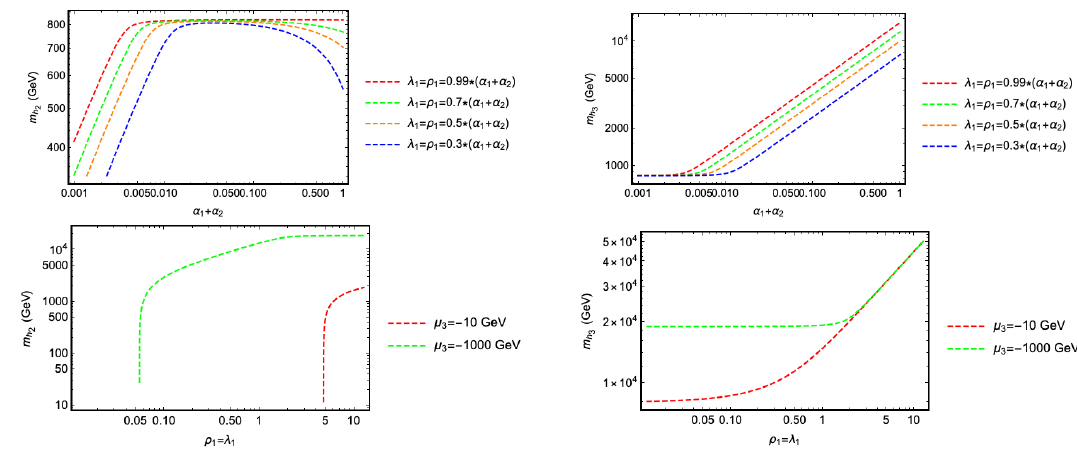
Figure 8 . Dependence on the Higgs mass on the couplings in the potential. Top left panel: h 2 Higgs mass as a function of α + α for various values of λ , in the lighter mass region; Top right 1 2 1 ρ 1 panel: same as in the left panel, but for h Higgs mass; Bottom left panel: h 3 function of λ = ρ , for two values of µ the heavier mass region; Bottom right panel: same as in 1 1 3 the left panel, but for h Higgs 3